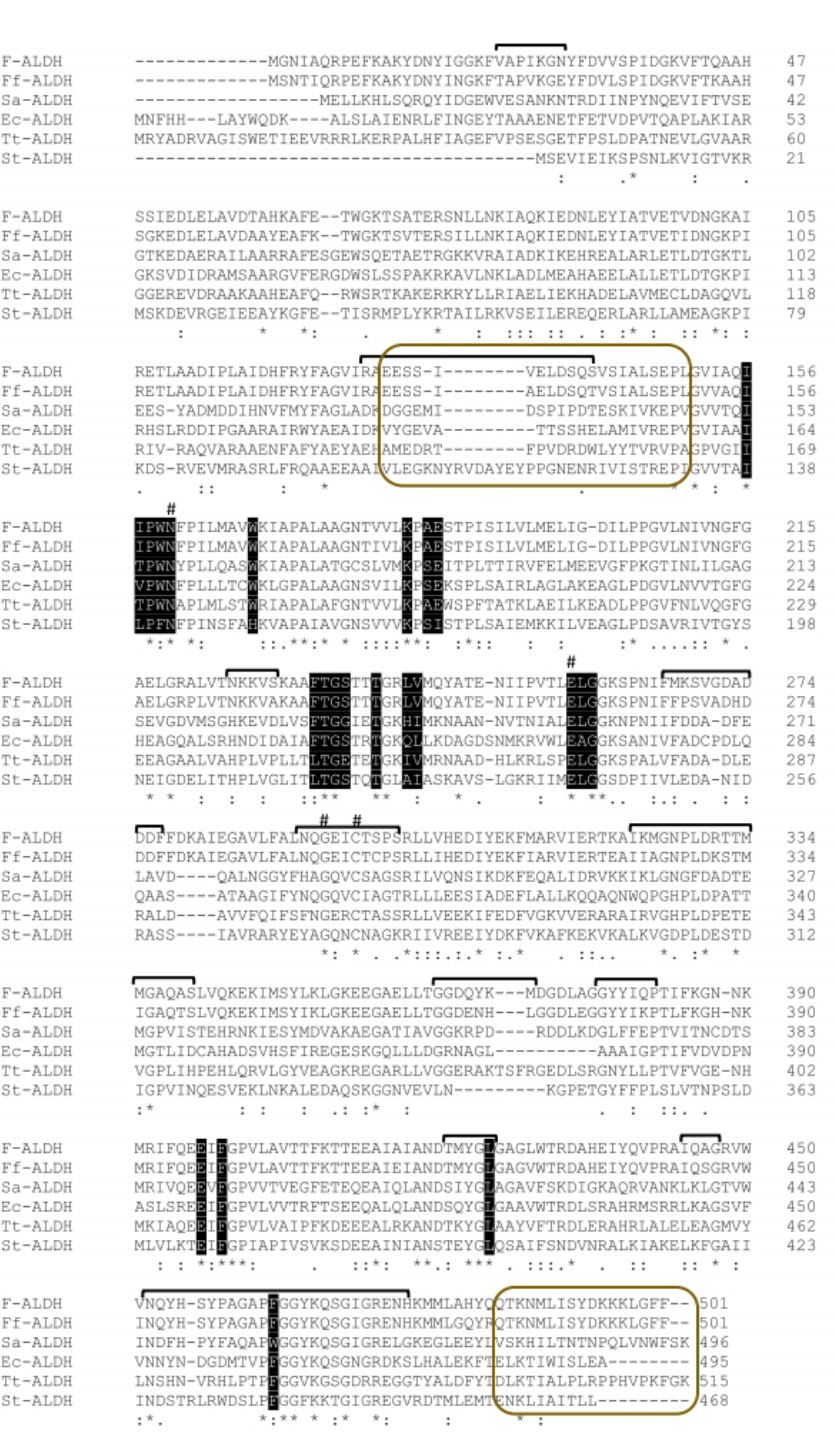
Figure 2. Multiple alignment of ALDH primary structure from psychrophilic, mesophilic, and ther- mophilic bacteria. Comparison of Flavobacterium PL002 F-ALDH [MH542427] with the homologous enzymes from the psychrophilic F. frigidimaris [AB085823], mesophilic S. aureus [WP_000421701.1] and E. [P23883.2], thermophilic T. thermophilus [WP_011173038.1], and hyperthermophilic archaeon S. tokodaii [WP_010978003.1]; identical (stars) and conserved (dots) residues from all enzymes; active site residues (grey shade); NAD + /NADP + cofactor binding site residues (black shade); aldehyde dehydrogenase motifs (PROSITE entry PS00687and PS00070)